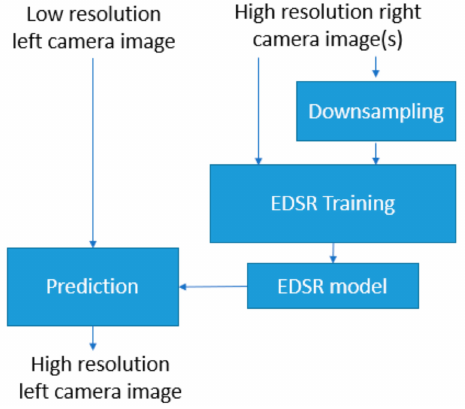
Figure 5. Processing steps of EDSR (training and